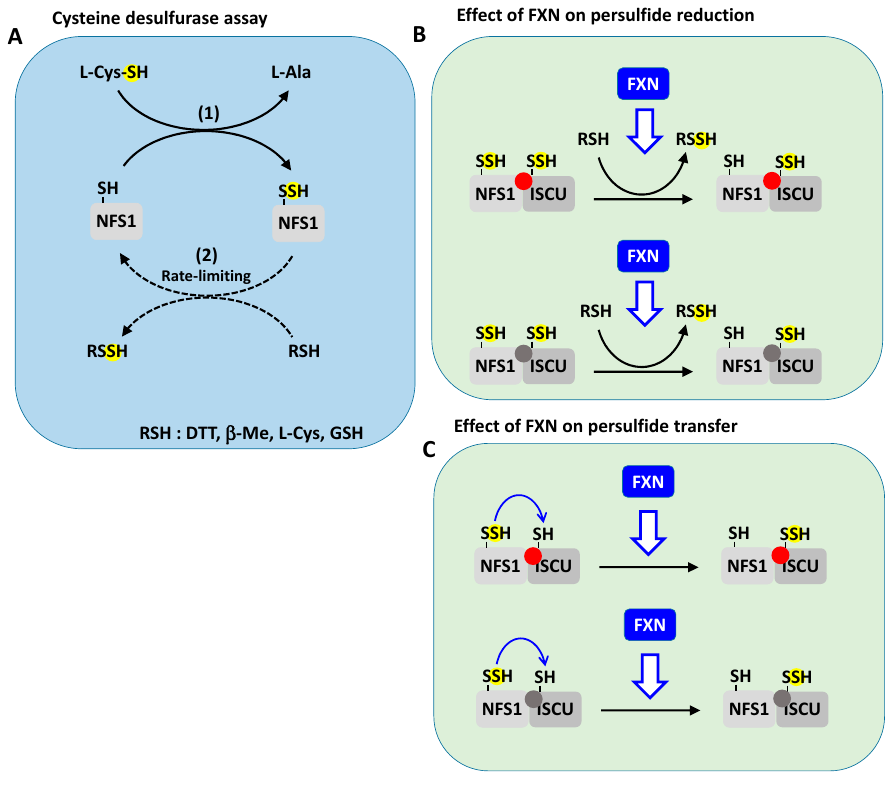
Figure 8. Effect of FXN on persulfide reduction and transfer. ( A ) The cysteine desulfurase assay encompasses two reactions: (1) formation of the persulfide and (2) its reduction by thiols (RSH). Reduction by thiols is the slowest step (rate-limiting step, dashed black arrows). ( B ) FXN accelerates the reduction of the persulfide of NFS1 by thiols in the NFS1–ISCU complex with ISCU metallated by iron (red ball) or zinc (gray ball). ( C ) FXN accelerates the transfer of the persulfide of NFS1 to ISCU in the NFS1–ISCU complex with ISCU metallated by iron (red ball) or zinc (gray ball). The solid blue arrow describes the transfer of persulfide. The blue arrows filled in white refer to acceleration by FXN.